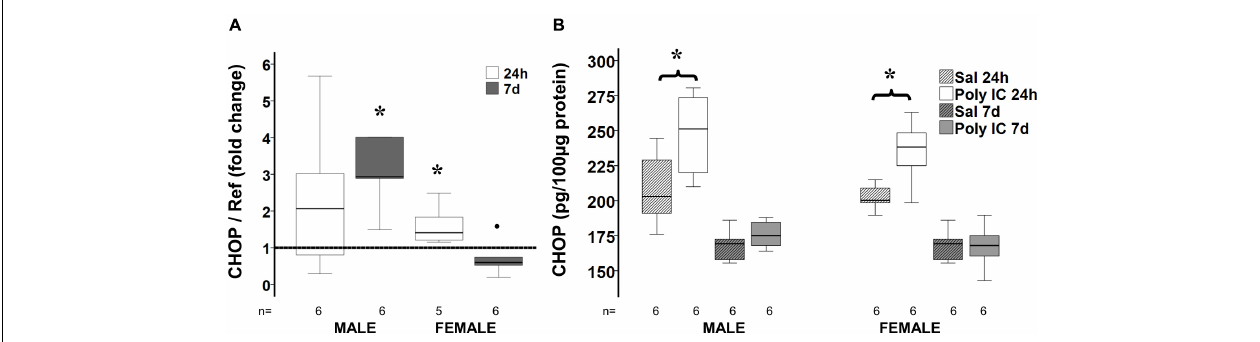
FIGURE 5 | Delayed sex-specific CHOP expression after poly I:C in P8 mice. Fold change in CHOP gene (A) and protein (B) expression at 24 h and 7 days after poly I:C exposure at P8. Data are shown using box and whiskers plots, where boxes are limited by the 75 th and 25 th percentiles (IQR) and whiskers are limited by the last data point within 1.5 times the IQR from the median (continuous line inside the box). Fold change was calculated relative to NS-treated mice shown as discontinuous line sitting at 1). ◦ , outlier (between 1.5 and 3 times the IQR); • , extreme ( > 3 times the IQR); ∗ p <